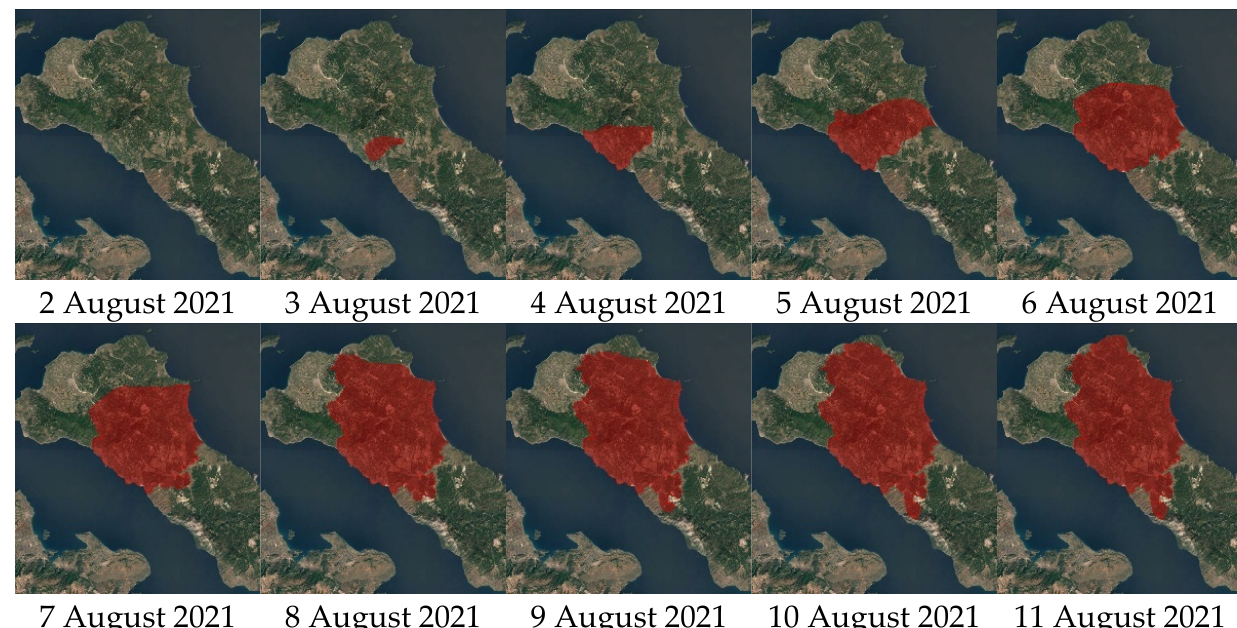
Figure 9. The total area of the fire was adapted by [76,77]. The evolution of the fire, adapted graph- ically in Google Earth [73] by satellite imagery [78,79], calibrated by the reports of 112 Emergency Communications Service